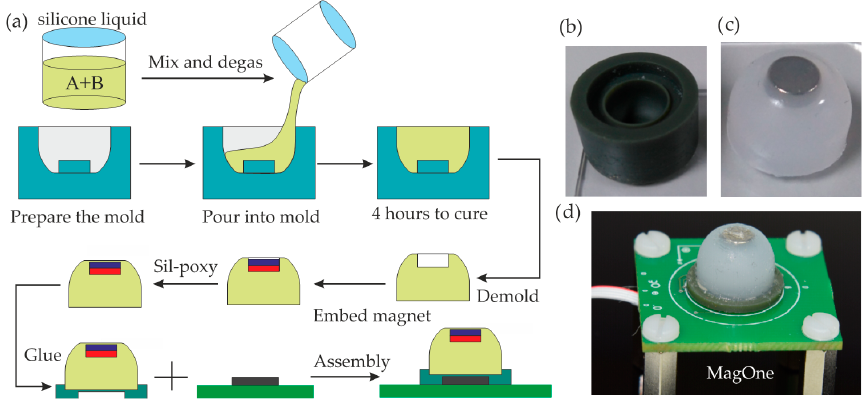
Figure 9. ( a ) Schematic of the fabrication process; ( b ) Photograph of the mould; ( c ) Photograph of the fabricated elastomer; ( d ) Photograph of the MagOne prototype.